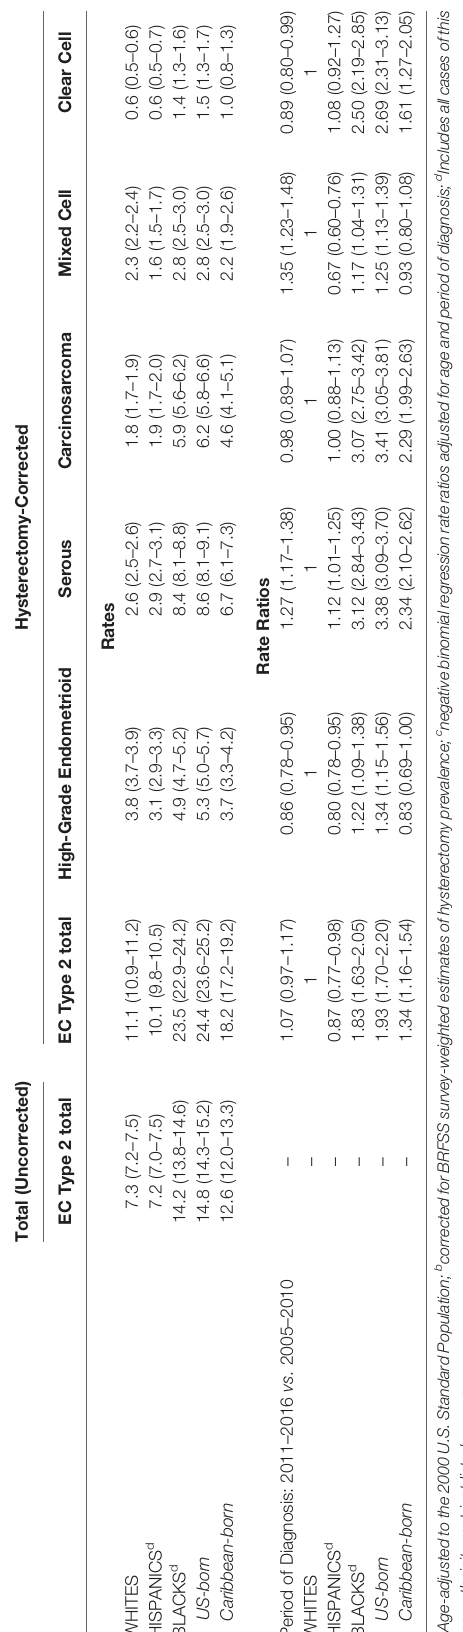
7.02 – 8.29) compared to those women diagnosed at localized stage. By EC2 subtype ( Figure 1 and Table 3 , Model 4), carcinosarcoma was associated with a two-fold higher risk of death (aHR=2.01, 95%CI: 1.87 – 2.16) compared to the reference high-grade endometrioid, while serous carcinoma was associated with a 15% higher risk of death (aHR=1.15, 95%CI: 1.06 – 1.23). Cox regression models were extended to include intra-racial (US-born and Caribbean-born Blacks) and intra-ethnic groups (Black Hispanics). All Blacks combined showed an overall higher risk of death (model 1, aHR =1.61, 95%: 1.52 – 1.71) compared to Whites. However, this disadvantage was considerably reduced (model 2, aHR=1.22, 95%CI: 1.14 – 1.30) after adjustment for EC2 subtype, stage at diagnosis, and socio-economic and healthcare factors (poverty level, insurance, and treatment) in model 4. Among non-Hispanic Blacks, the results suggest some advantage for Caribbean-born Blacks with 8% lower endometrial cancer- ( Table 3 , Model 4). Black Hispanics showed the lowest risk of death of all African-descent populations ( Figure 2 ). After adjusting for all predictors, Black Hispanics had a 24% lower risk of death (model 4, aHR=0.76, 95% CI: 0.61 – 0.95) compared to US-born